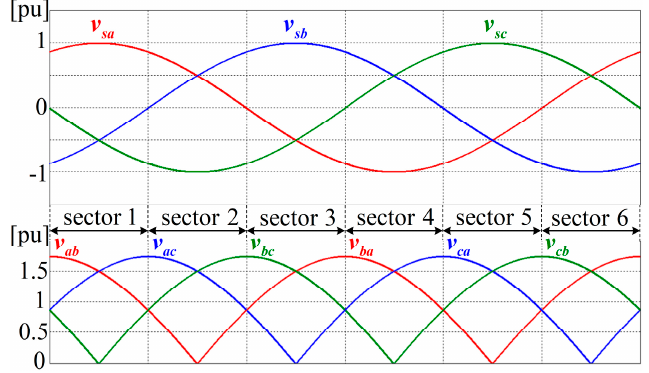
Figure 3. Input phase and line-to-line voltages at main power supply.